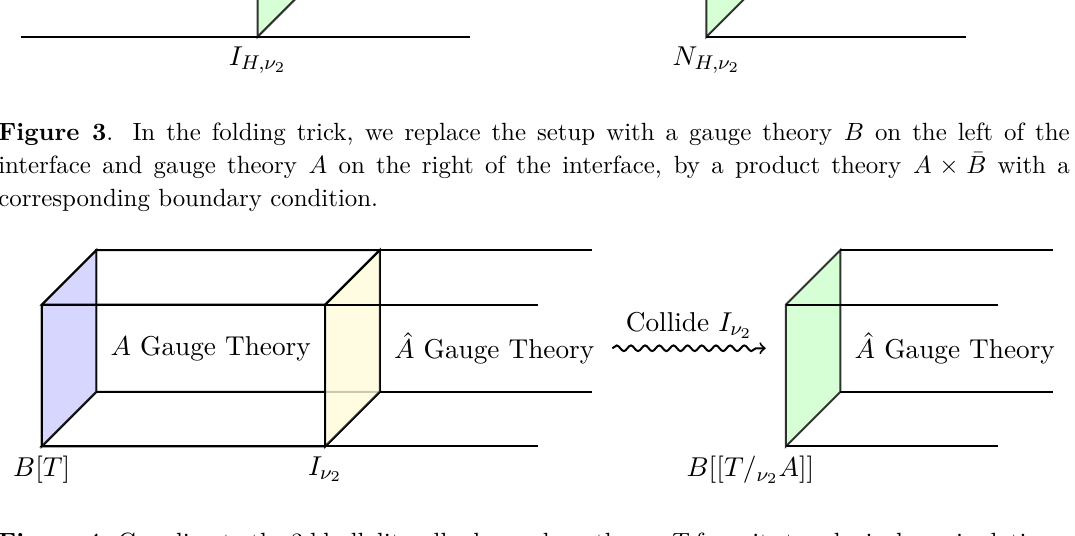
Figure 4 . Coupling to the 3d bulk literally decouples a theory T from its topological manipulations. If T corresponds to some boundary condition B [ T ] (in blue), and some topological manipulation corresponds to the interface I (in yellow), we may produce the theory with the topological ma- ν 2 nipulation included (in green), by colliding the boundary B [ T ] with I ν 2